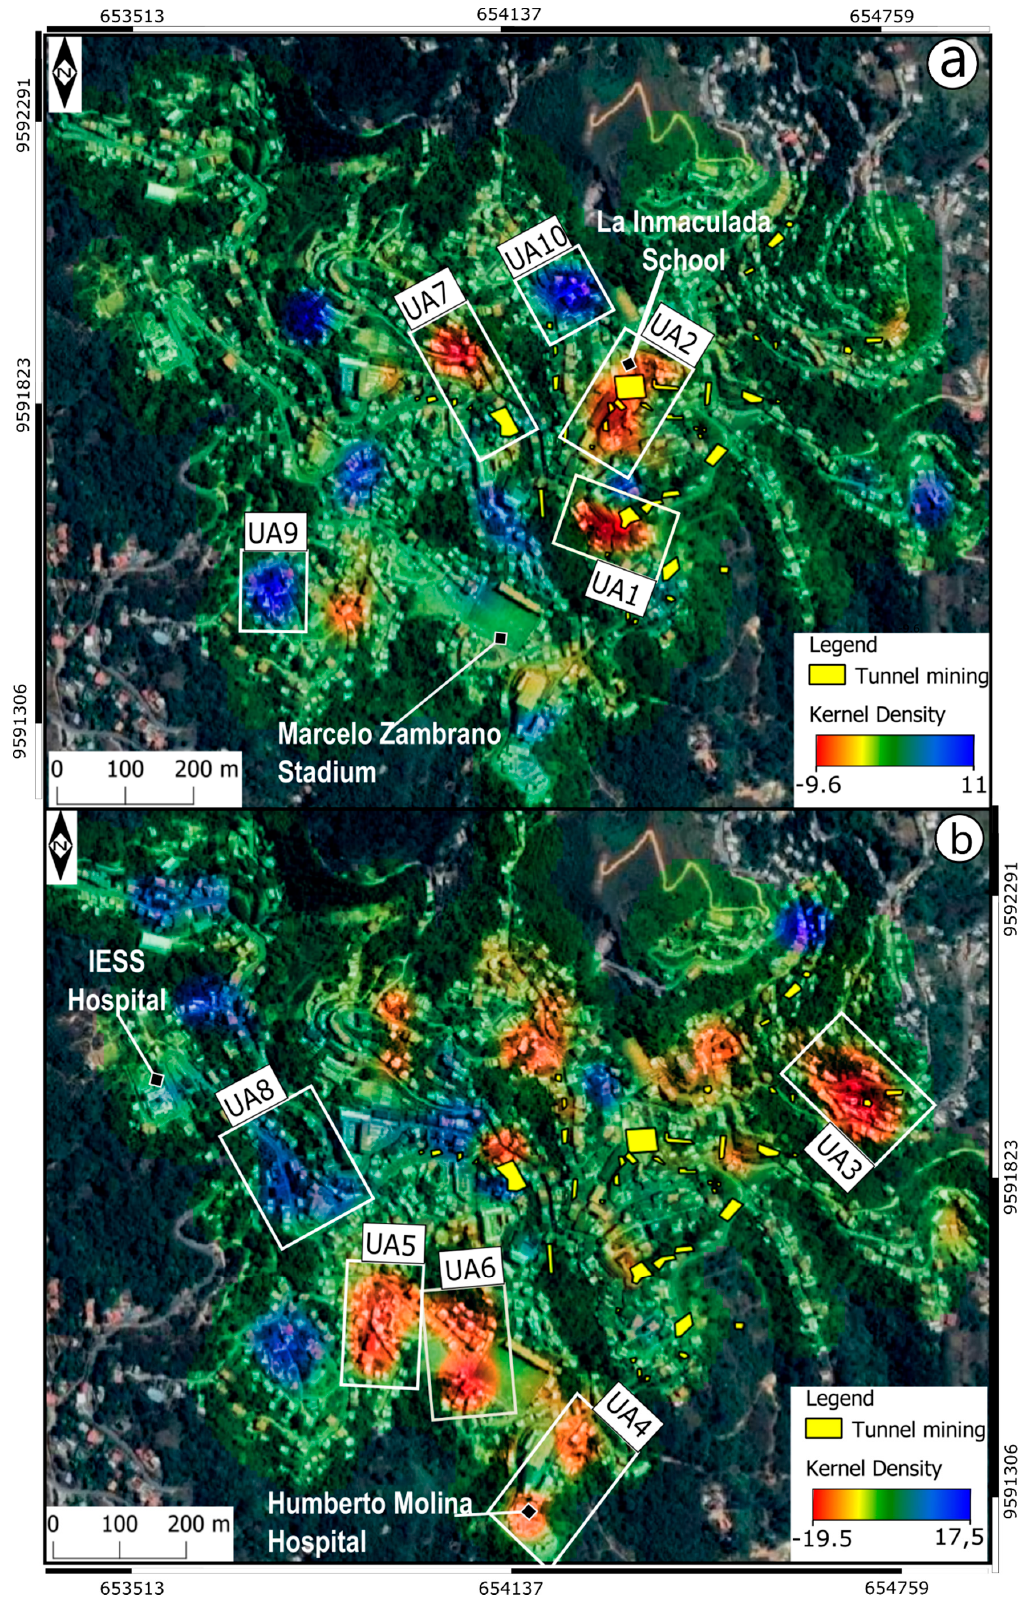
Figure 7. Kernel density map: a ) ascending orbits; b ) descending orbits.